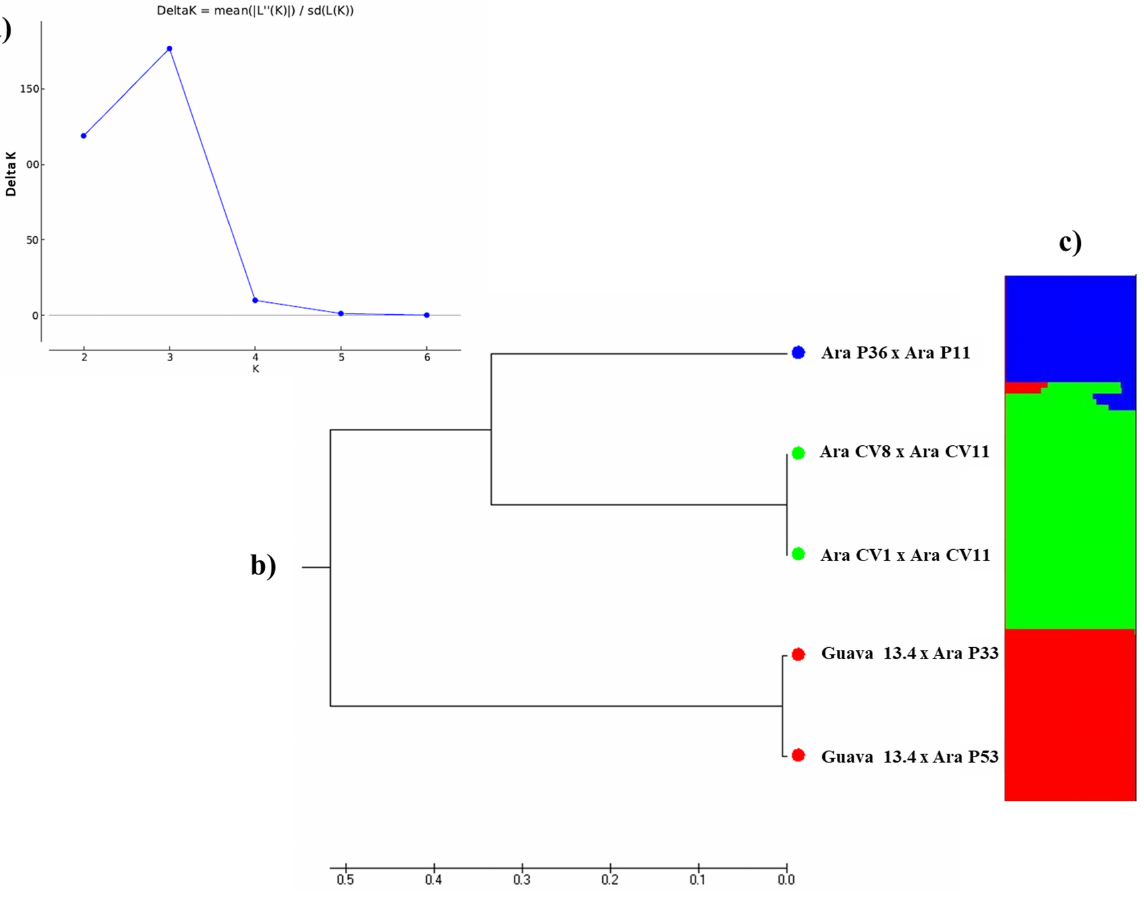
Figure 3: a) Delta K (ΔK) values for the respective numbers of groups (K) in five populations obtained from interspecific crosses of Psidium spp; b) Dendrogram generated by the UPGMA method based on Nei’s genetic distance for the five populations obtained from interspecific crosses of Psidium spp; c) Clustering by Bayesian inference in five populations obtained from interspecific crosses of Psidium spp. with k = 3